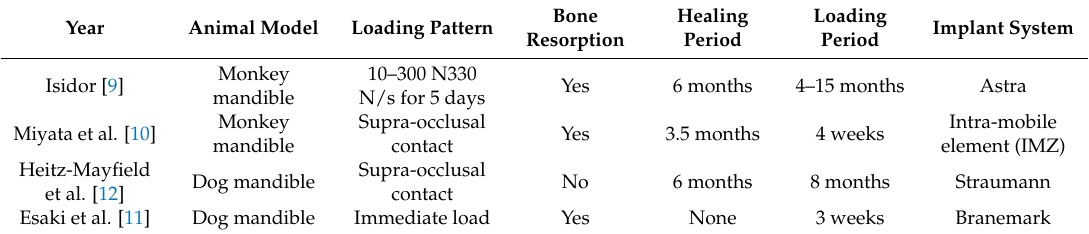
Table 1. Animal experiments about biological complications related to implant